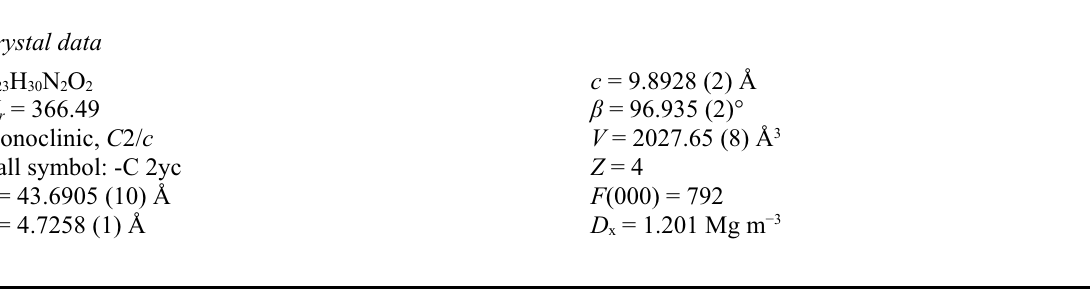
View of the molecular structure of (I) at the 70% probability level. Hydrogen atoms are drawn as spheres of arbitrary radius. The unlabelled atoms are generated by the symmetry operation (1–x, y, 1/2–z). 2,2 ′